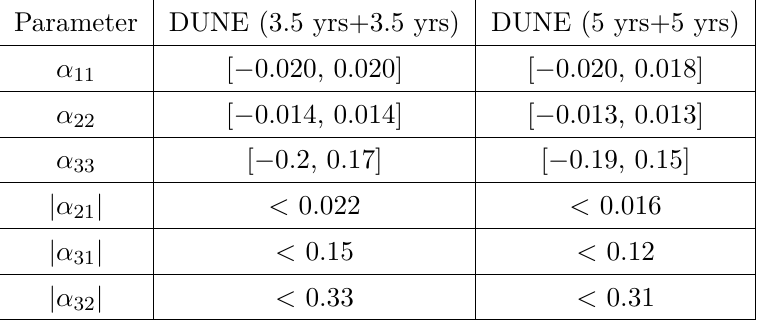
Table 7 . 90% C.L. (1 d.o.f.) limits on the NUNM parameters considering two different exposures of DUNE: total run-time of 7 years (see second column) and 10 years (see third column) equally divided in neutrino and antineutrino